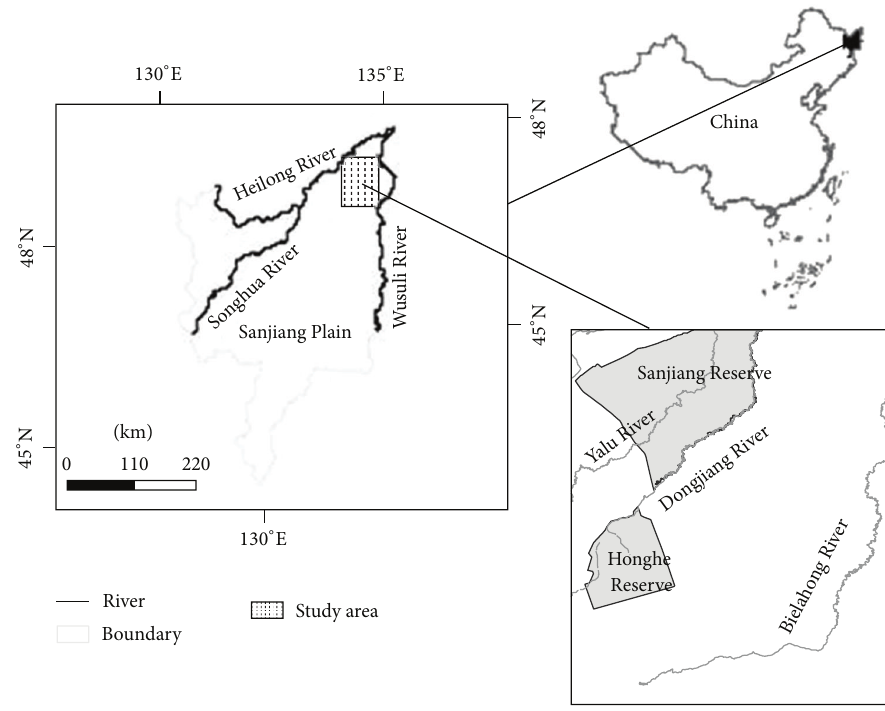
Figure 2: Location of the study area in Sanjiang Plain,